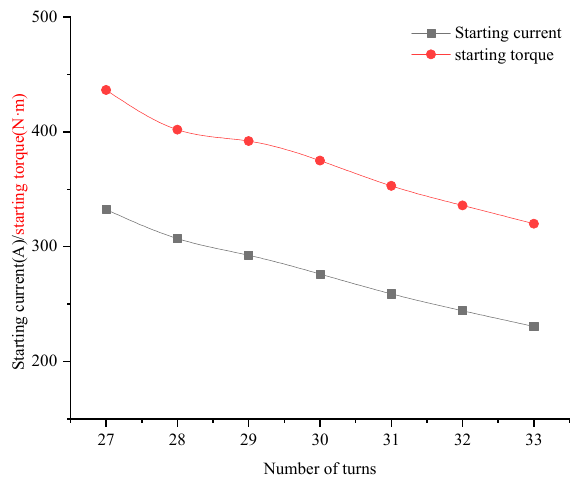
Figure 12. The starting current and starting torque of LSPMSM.